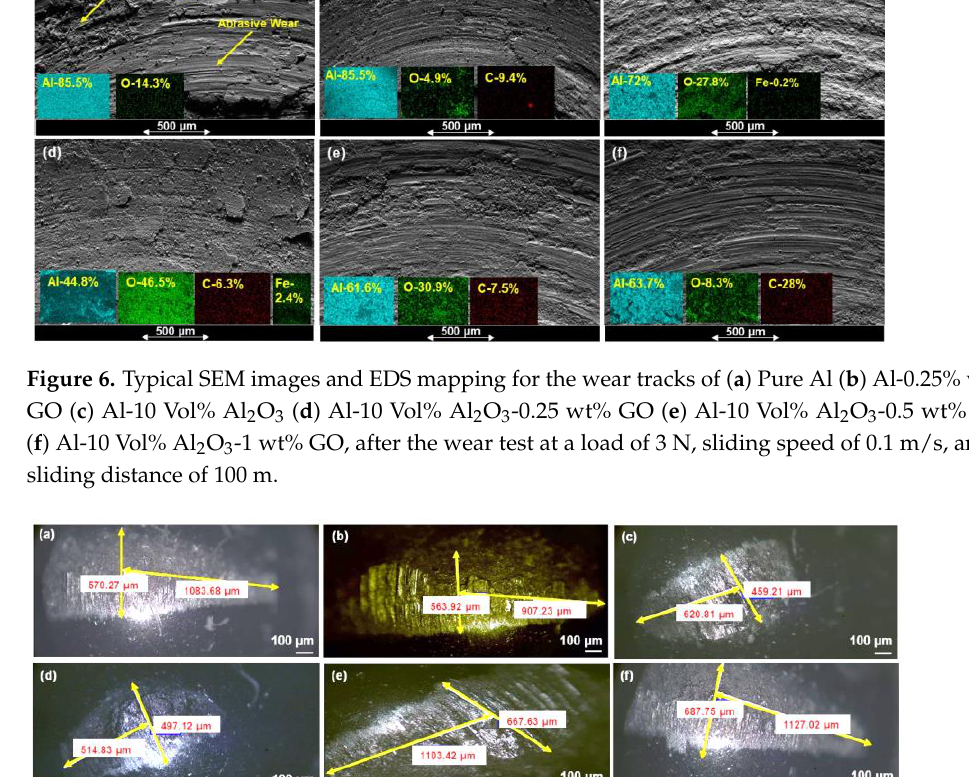
Figure 7. Typical optical counterface ball images sliding against: ( a ) Pure Al ( b ) Al-0.25 wt% GO ( c ) Al-10 Vol% Al 2 O 3 ( d ) Al-10 Vol% Al 2 O 3 -0.25 wt% GO ( e ) Al-10 Vol% Al 2 O 3 -0.5 wt% GO ( f ) Al-10 Vol% Al 2 O 3 -1 wt% GO, after the wear at a load of 3 N, sliding speed of 0.1 m/s, and a sliding distance of 100 m.